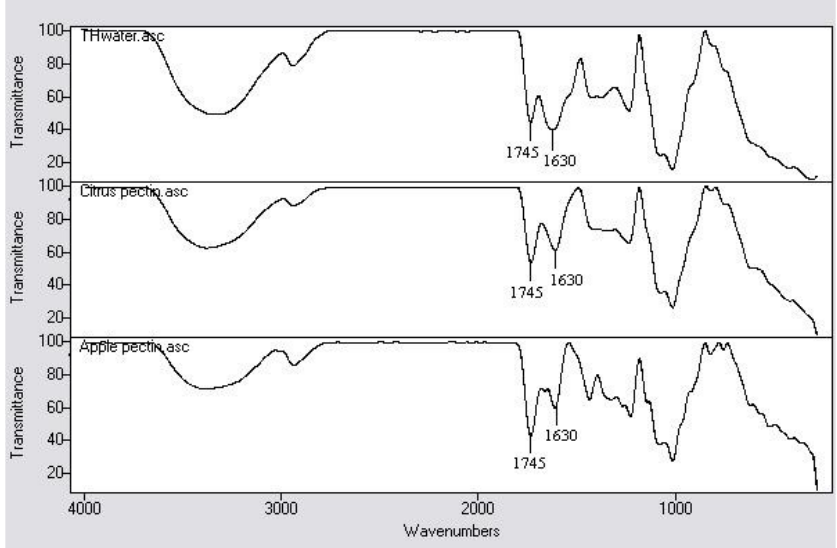
), citrus and apple water